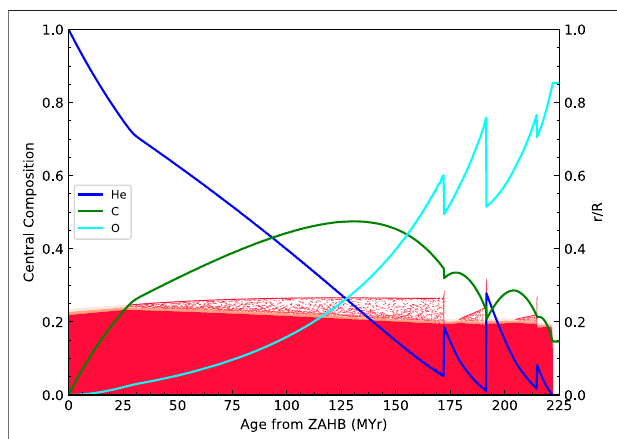
FIGURE 13 | Evolution of the convective core (red-shaded area) and central C, O, and He mass fractions throughout the core helium-burning phase in the representative EHB evolutionary sequences computed with STELUM. The core evolution experience three main phases : 1) a steady core growth until X (He) ~ 0.7, 2) the development of a partially mixed (semi- convective) region above the fully convective core whose size increases over time, and 3) the onset of breathing pulses when X (He) reaches ~ 0 . 05 for the fi rst time. The three breathing pulses occurring in the model turn out to be the key events that raise the oxygen mass fraction up to ~ 0 . 86 at the time of core helium exhaustion. Our seismic measurements of the central oxygen mass fraction in white dwarfs are remarkably consistent with this value. These can be seen as evidence that breathing pulses are not numerical artefacts from models and that helium-burning cores indeed experience such